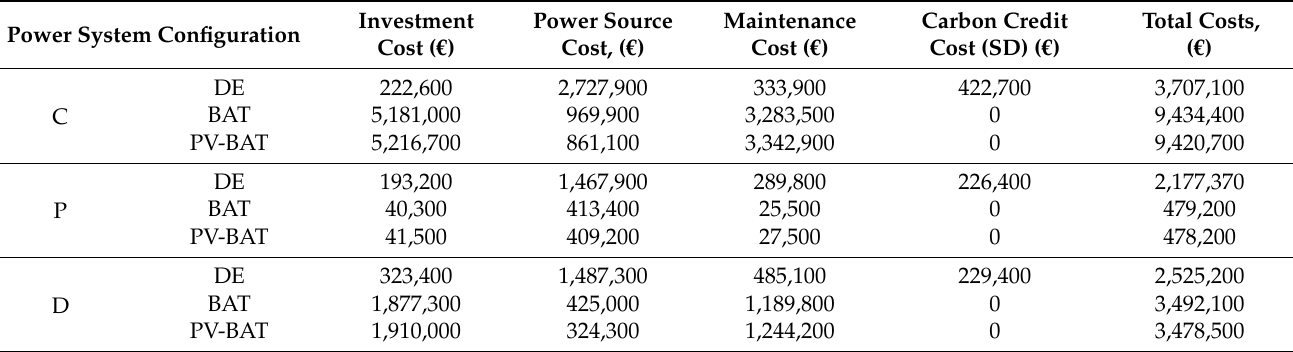
Table 9. Policy impact on LCCs of the considered